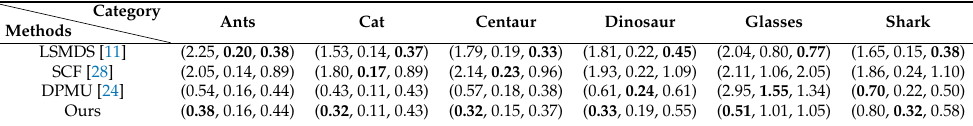
Table 1. Comparisons on the same category. Numbers in each cell ( · , · , · ) represent the mean of E rig (left), E str (middle) and E geo (right) for the same category, respectively. For each class, the best is highlighted.